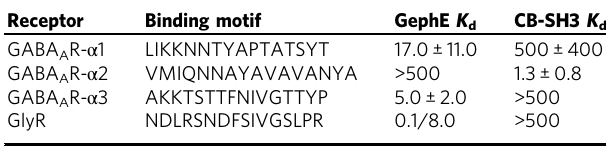
Table 1 K d values for the α 1 – 3 subunits and glycine receptors with gephyrin (GephE) or CB (CB-SH3)